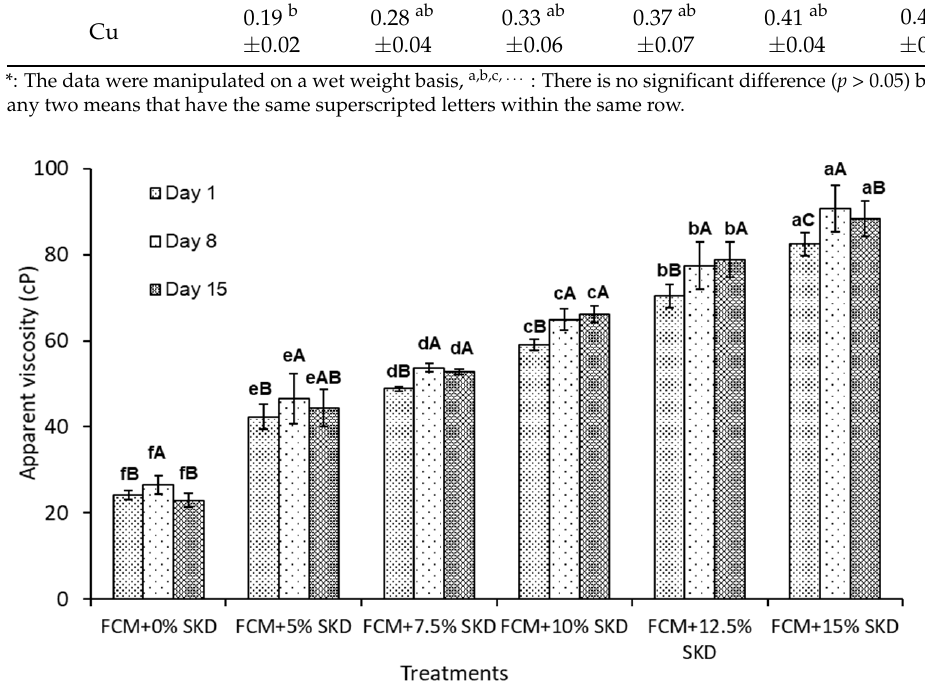
Figure 1. The effect of adding SKD at 5, 7.5, 10, 12.5, and 15% to FCM on the AV of probiotic-enriched FCM over 15 days at 5 °C, the AV was measured using Fungilab apparatus (Barcelona, Spain) with spindle R2, rotation speed 100 rpm and expressed as cP, measurements were made for 1 min at 10 °C. a,b,c,….. : Bars within the same storage day not sharing a common letter are significantly different ( p < 0.05). A,B,C : Bars not sharing a common letter during the storage periods are significantly different ( p <